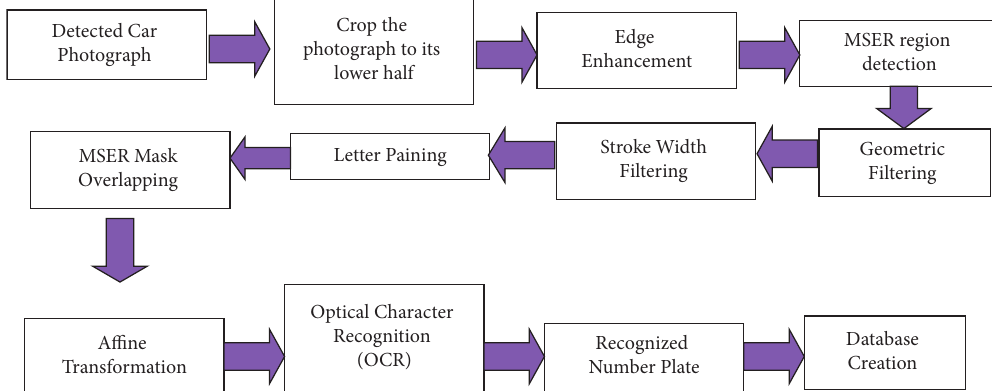
Figure 10: Flowchart of the methods used to detect and recognize the number plate of a vehicle.